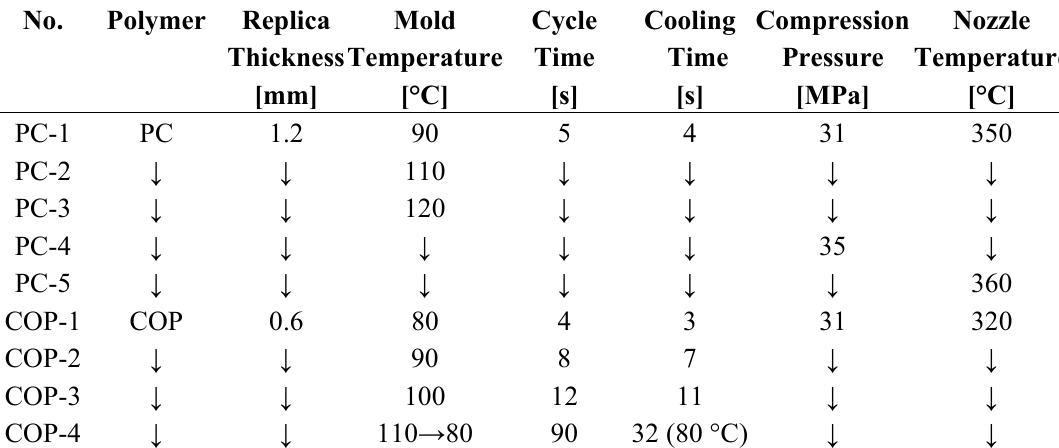
Table 1. Conditions of